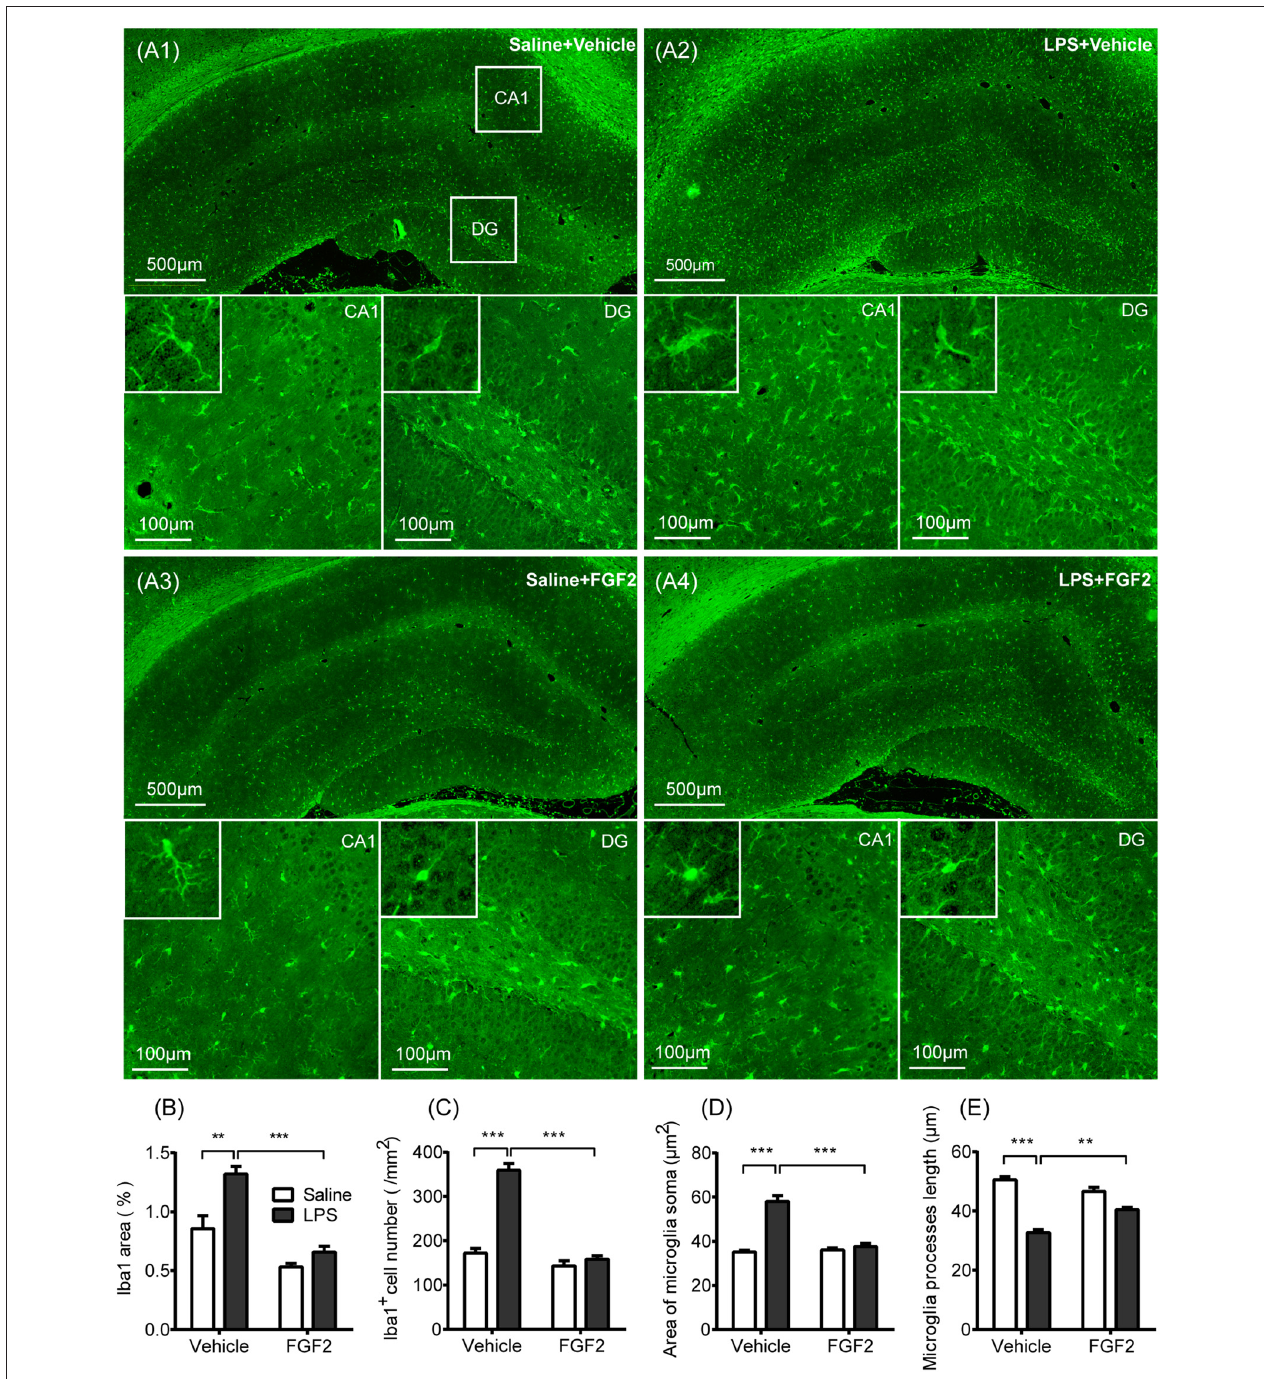
FIGURE 2 | FGF2 decreased microglia activation in hippocampus induced by central LPS treatment. (A1–A4) Representative photographs of the ionized calcium-binding adaptor molecule-1 (Iba1) expression in hippocampus. In LPS + Vehicle group, there were increased expression of microglia identification marker Iba1 and more Iba1 positive cells in CA1 and DG with the swollen soma and retracted processes. In LPS + FGF2 group, the number and morphology of Iba1 positive cells were closer to the control group. (B) The comparison of the percentage of Iba1 positive area. The increased Iba1 area was reversed by FGF2 in LPS-treated rats. (C) The comparison of the density of Iba1 positive cells. The increased Iba1 cell density was reversed by FGF2 in LPS-treated rats. (D) The comparison of the microglial soma area. The increased soma area was reversed by FGF2 in LPS-treated rats. (E) The comparison of microglia processes length. The decreased processes length was reversed by FGF2 in LPS-treated rats. Two-way ANOVA with Tukey’s multiple comparisons test, n = 4 per group. Data are presented as the means ± SEM. ∗∗ p < 0.01, ∗∗∗ p < 0.001. LPS, lipopolysaccharide; FGF2, fibroblast growth factor 2; DG, dentate gyrus.